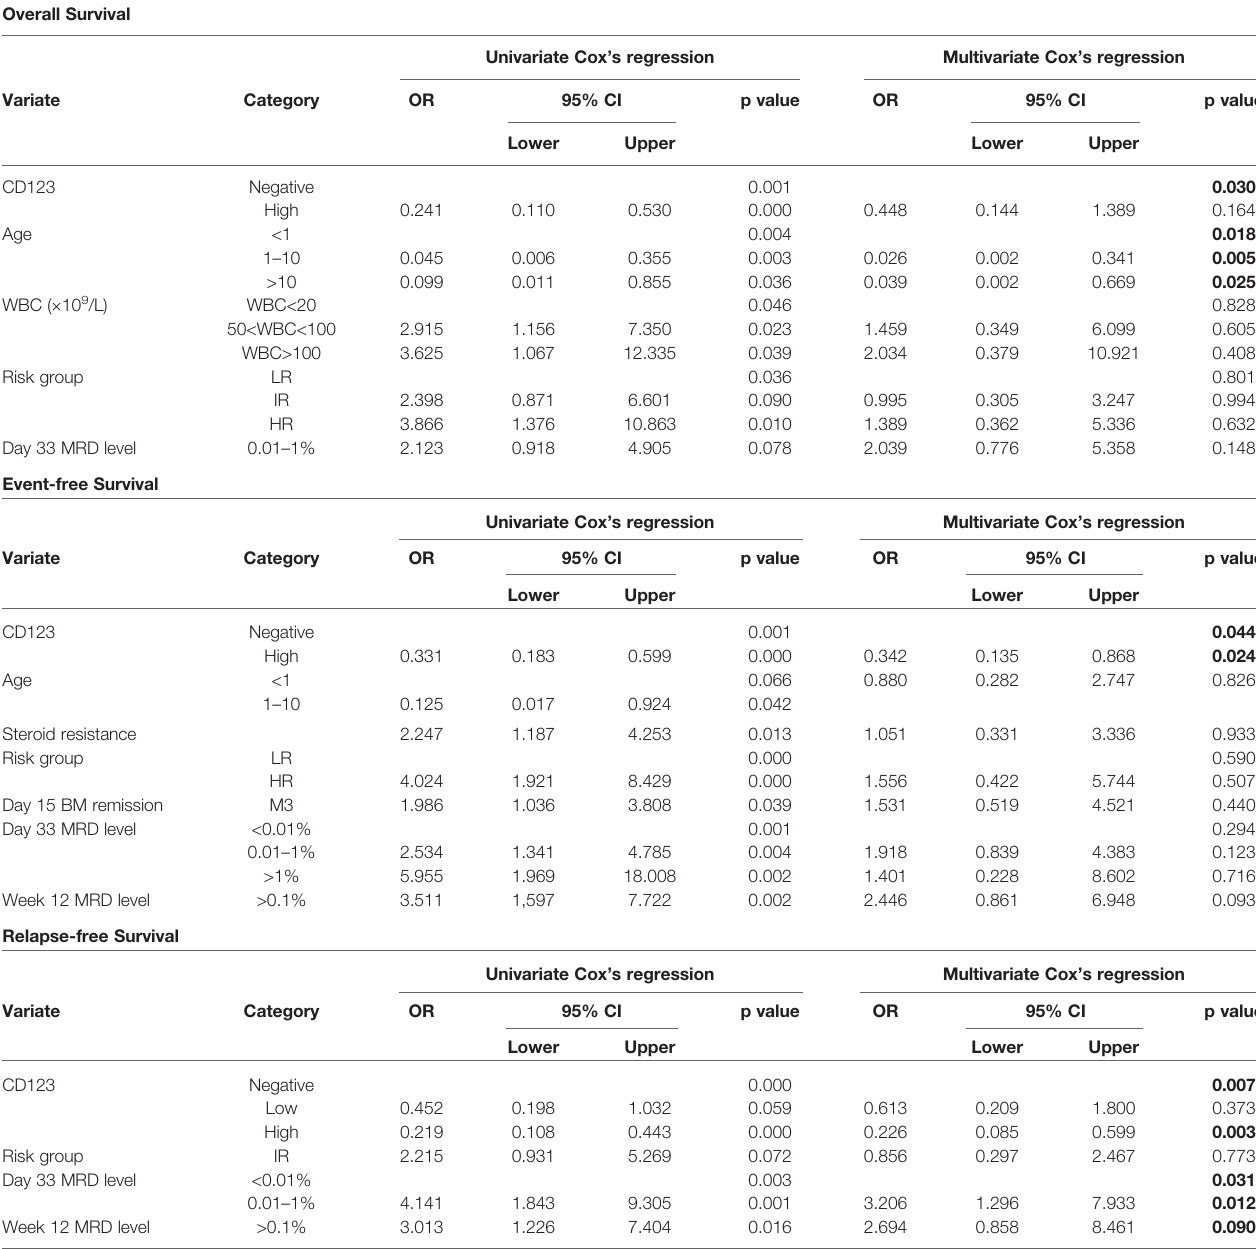
TABLE 5 | Prognostic factors for therapeutic outcomes of patients lacking prognosis-de fi ning genomic abnormalities in CCLG-ALL-2008